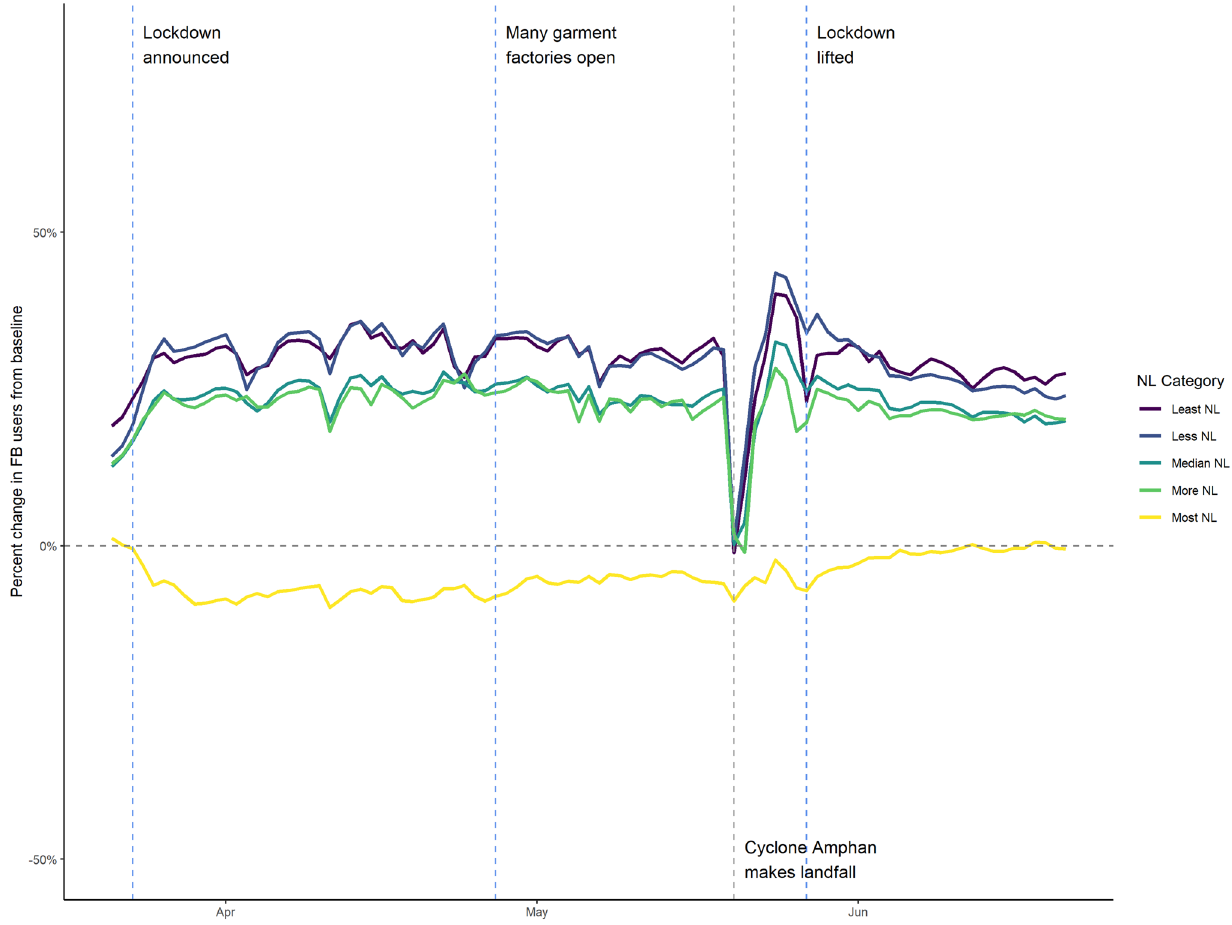
Figure 4. Percent change in population of Facebook users categorized by five equally sized quantiles of nightlight in Bangladesh with data aggregated at the ADMIN2 level of spatial